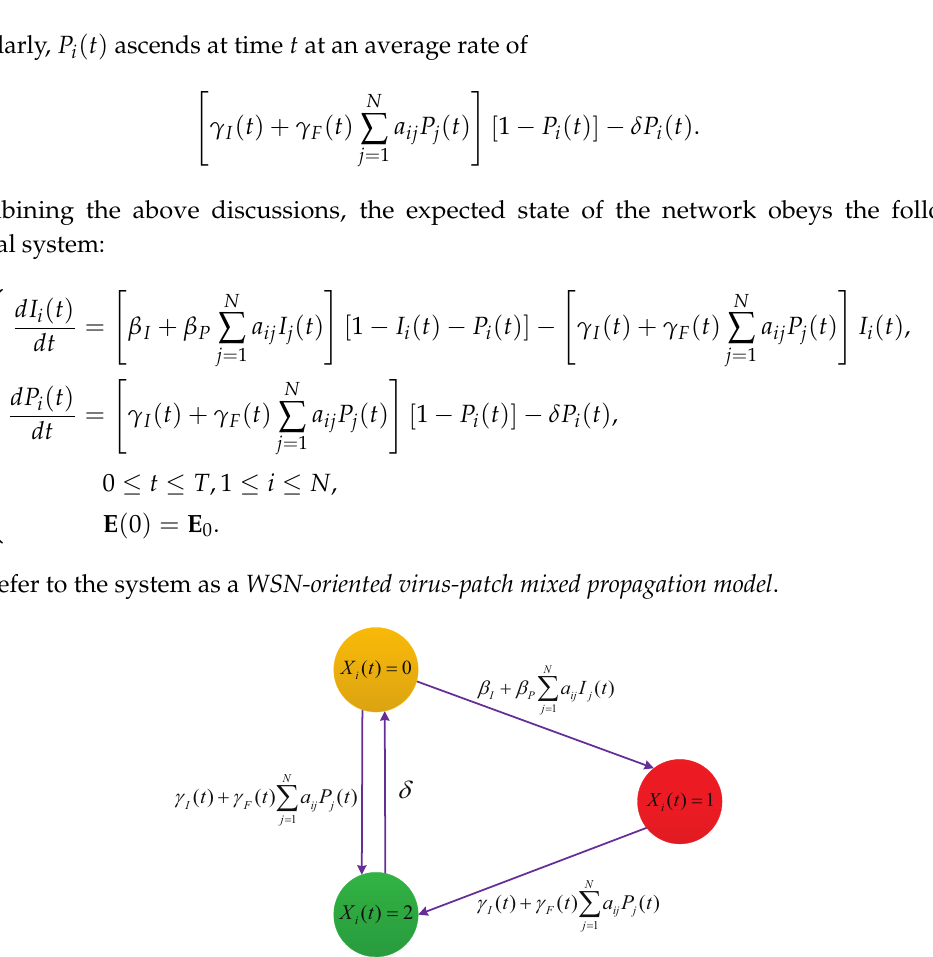
Figure 3. Diagram of the hypotheses (H 1 )–(H 5